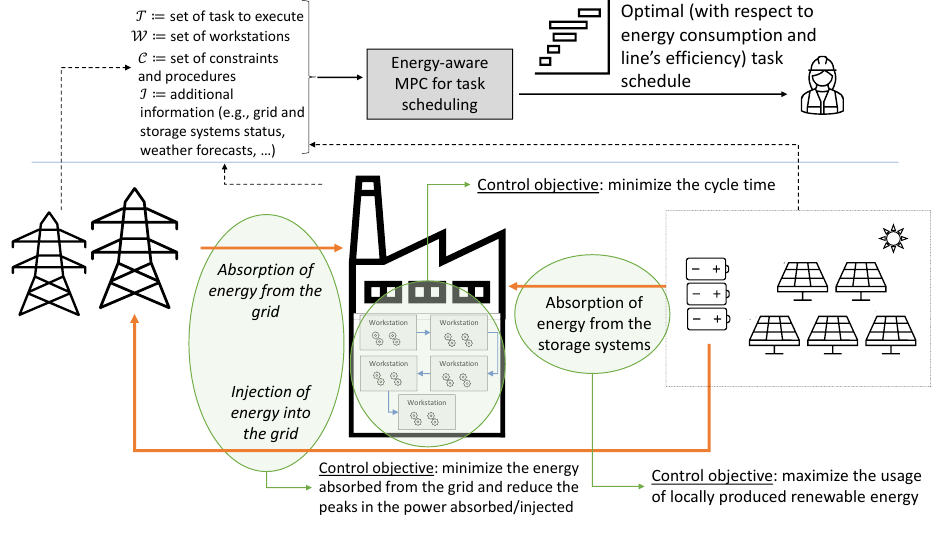
Figure 1. Reference